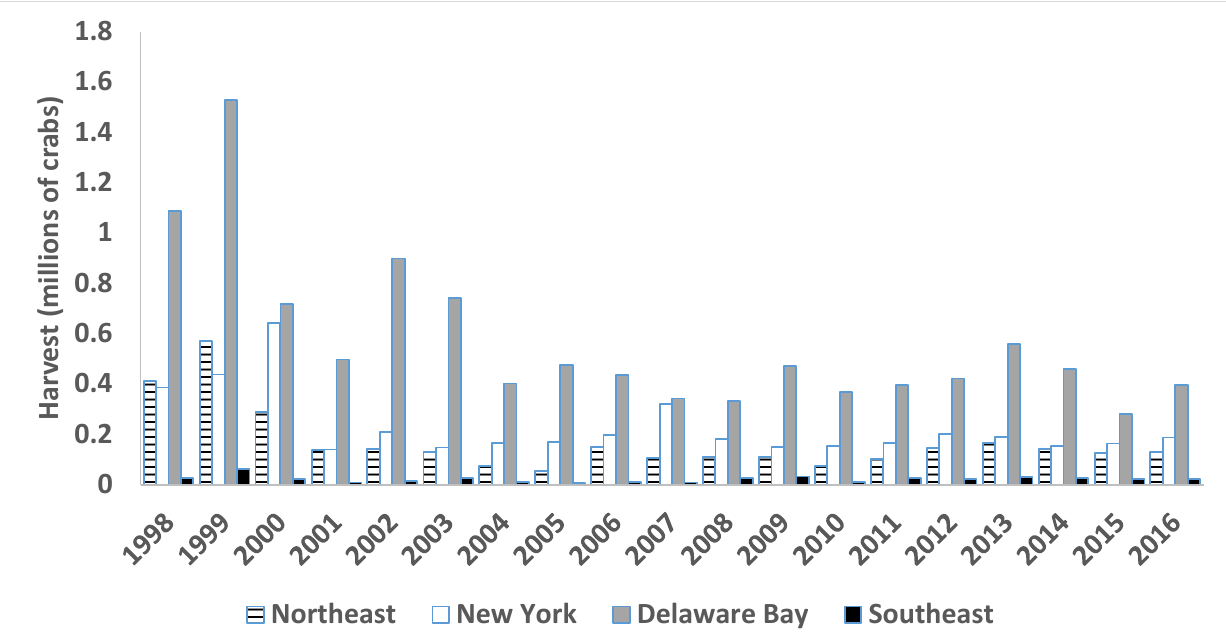
Figure 4. Horseshoe crab bait harvest by region, 1998-2016. The four regions are the Northeast (Maine, Massachusetts, Rhode Island), New York (Connecticut, New York), Delaware Bay (New Jersey, Delaware, Maryland, Virginia), and Southeast (North Carolina, South Carolina, Georgia,